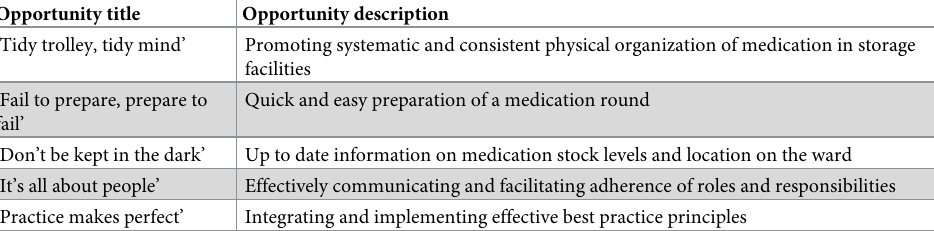
Table 5. Opportunity titles and descriptions for a prototype solution for testing to address the medication storage challenges